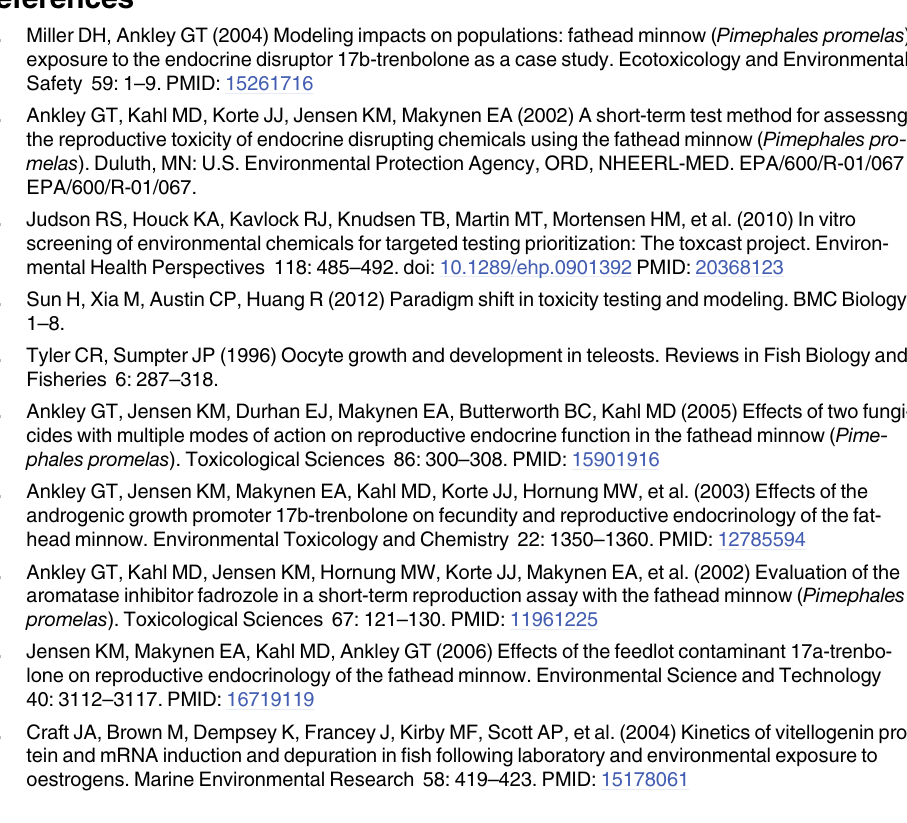
S3 Fig. Fenarimol OGDM predictions: (A) reproduction metrics; (B) average cumulative fecundity. S4 Fig. Trilostane OGDM predictions: (A) reproduction metrics; (B) average cumulative fecundity. S1 Table. Data for control fathead